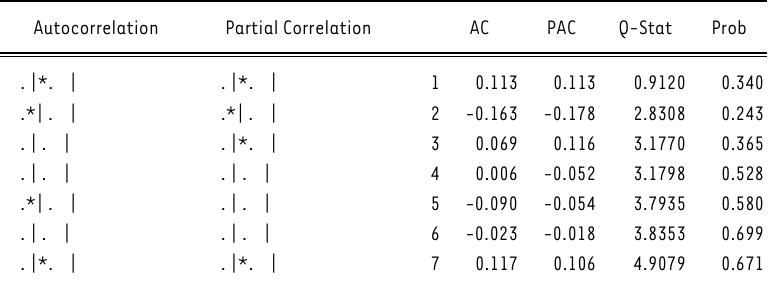
FIGURE 2: Residuals Normality Test TABLE 4: Residuals Autocorrelation Test Sample: 1946